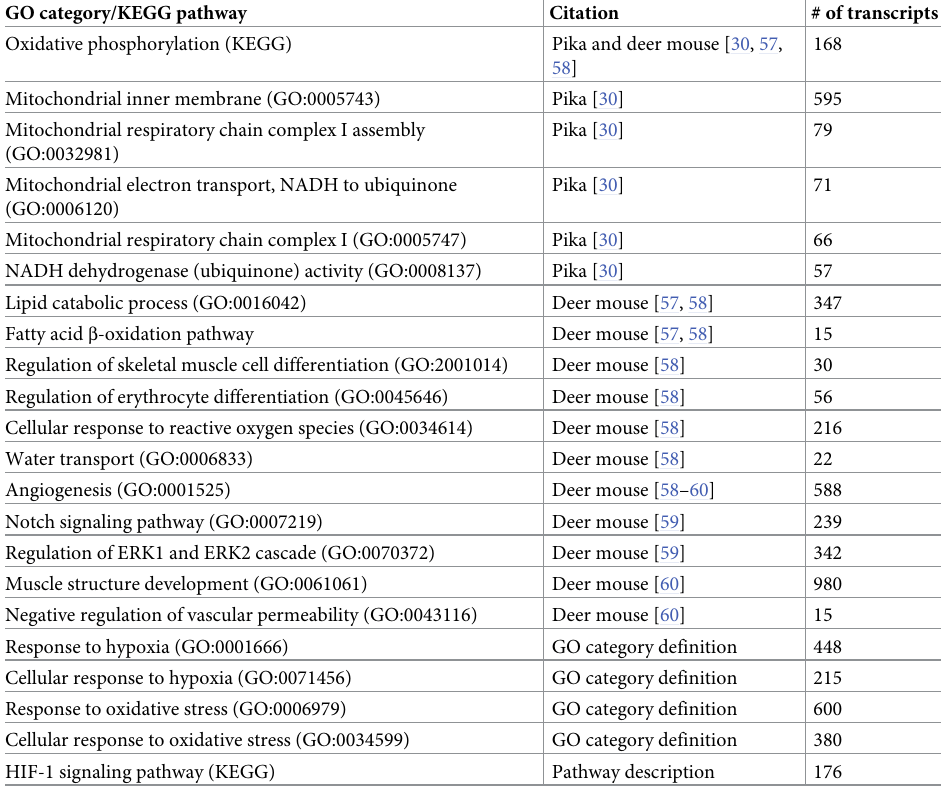
Table 1. Gene sets used in GSEA. GO category/KEGG